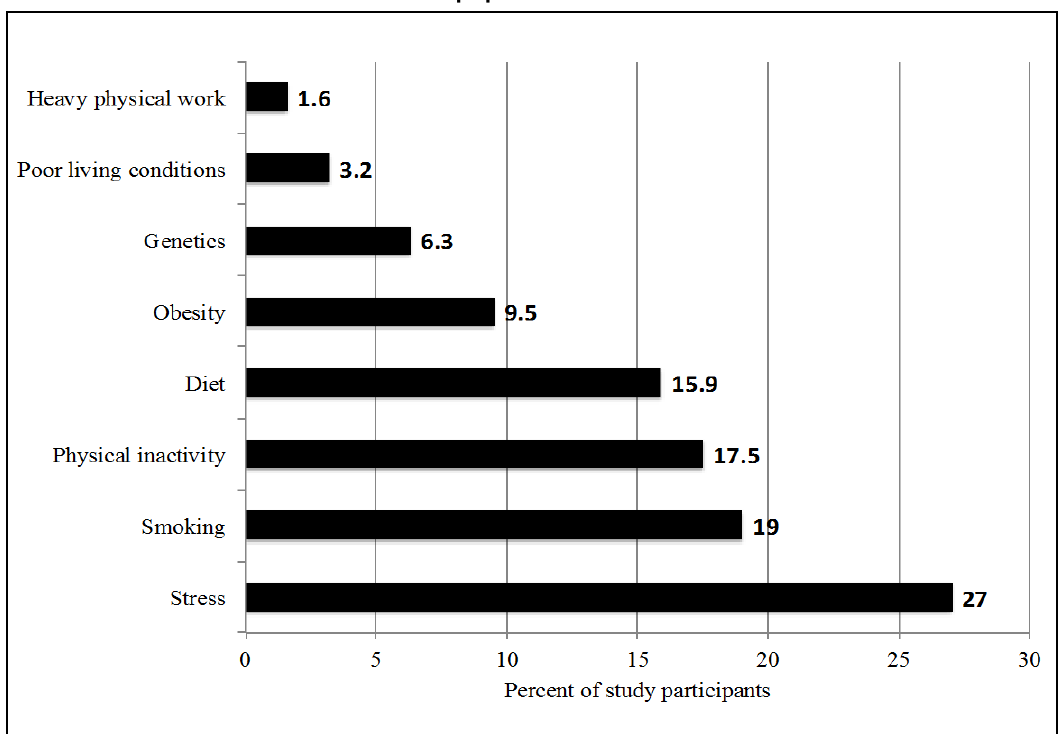
Figure 3. The risk factor that predominantly contributes to poor health and high mortality of the adult population in